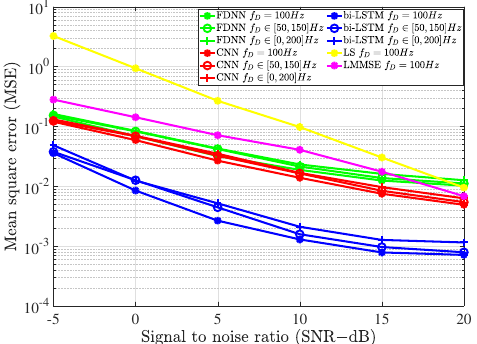
Figure 17. The impact of a Doppler frequency mismatch on the deep learning-based channel